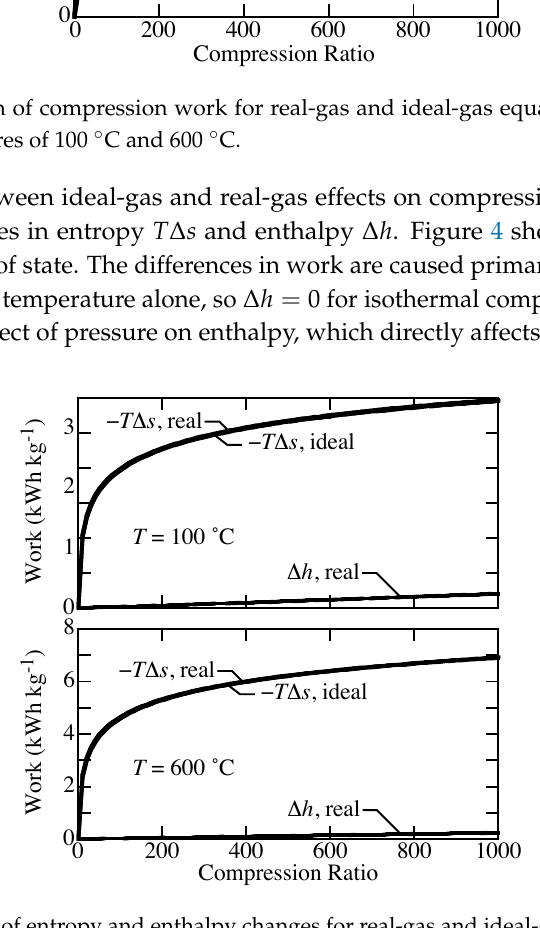
Figure 4. Comparison of entropy and enthalpy changes for real-gas and ideal-gas equations of state for compression from 1 bar to 1000 bar at 100 ◦ C and 600 ◦